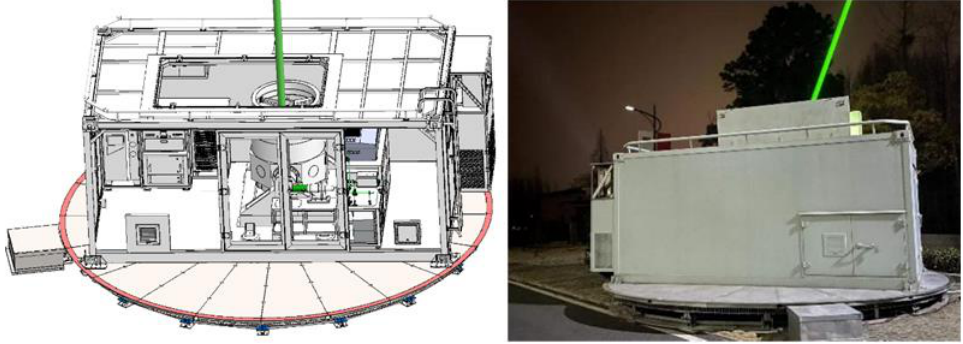
Figure 2. Structure diagram and photo of the rotary lidar system.